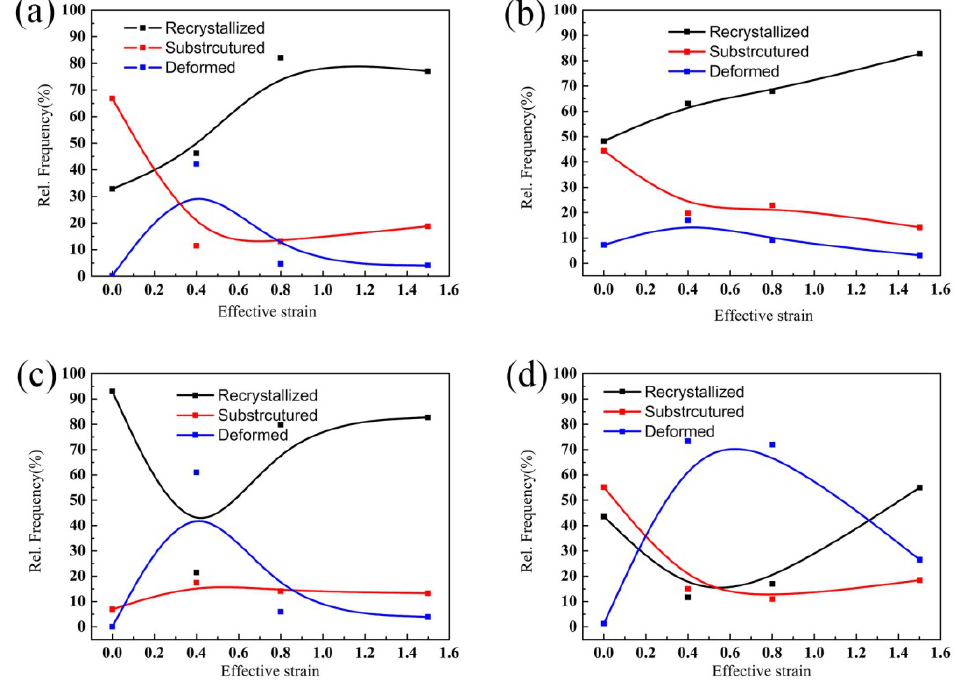
Figure 10. Volume fraction of DRX grains, substructure grains and deformed grains at: ( a ) 960 ° C, ( b ) 990 ° C, ( c ) 1010 ° C, ( d ) 1040 ° C.